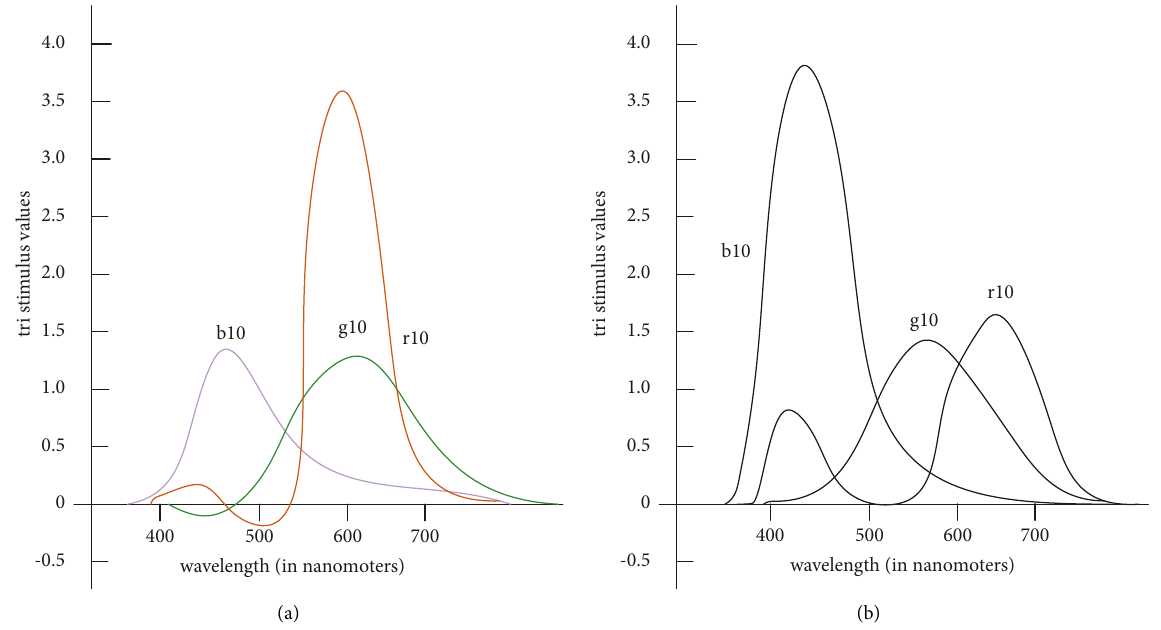
Figure 5: Statistics of color distribution under different models. (a) RGB color model. (b) XYZ color